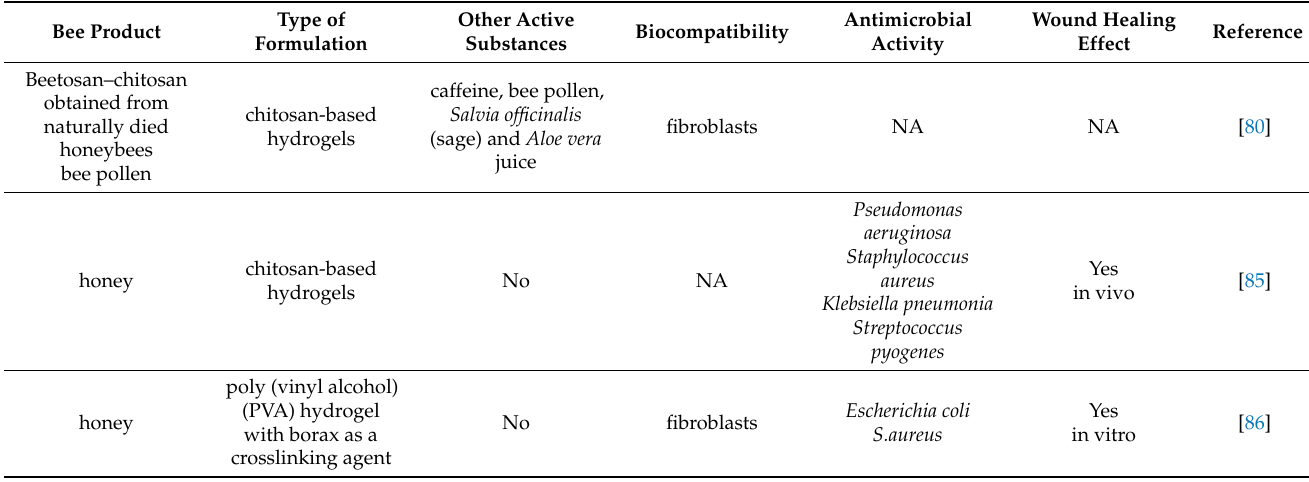
Table 1. Newly developed formulations based on bee products to promote the wound healing process. Type of Bee Product